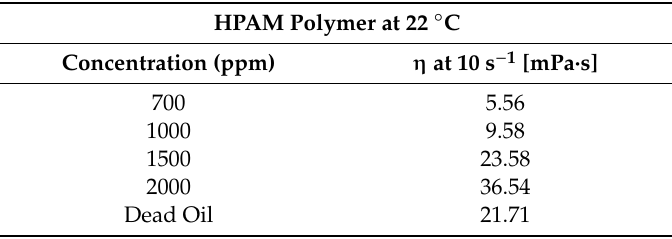
Figure 4. Shear viscosity of polymer solutions at temperature of 22 °C. Table 6. Polymer concentrations and viscosity at a shear rate of 10 s − 1